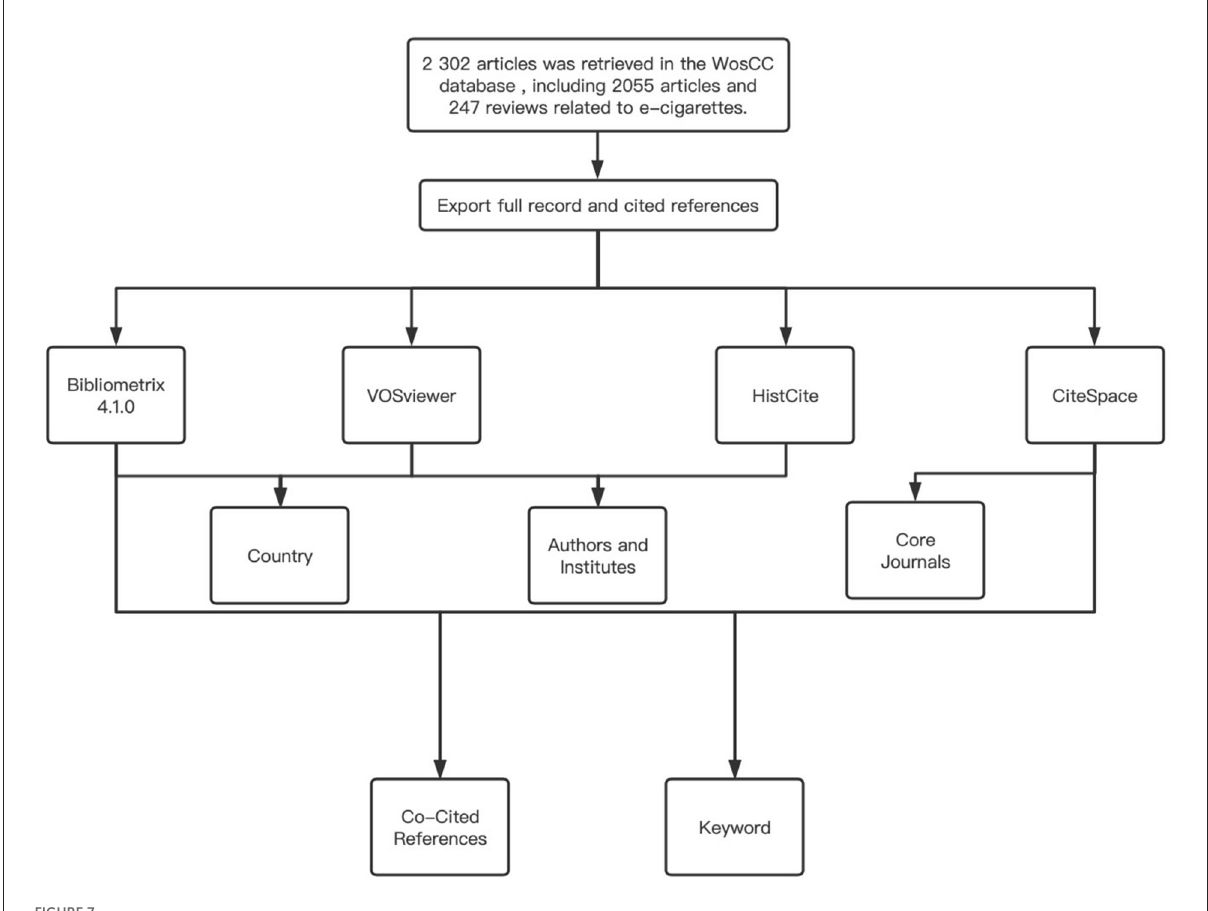
FIGURE7 Methods flow